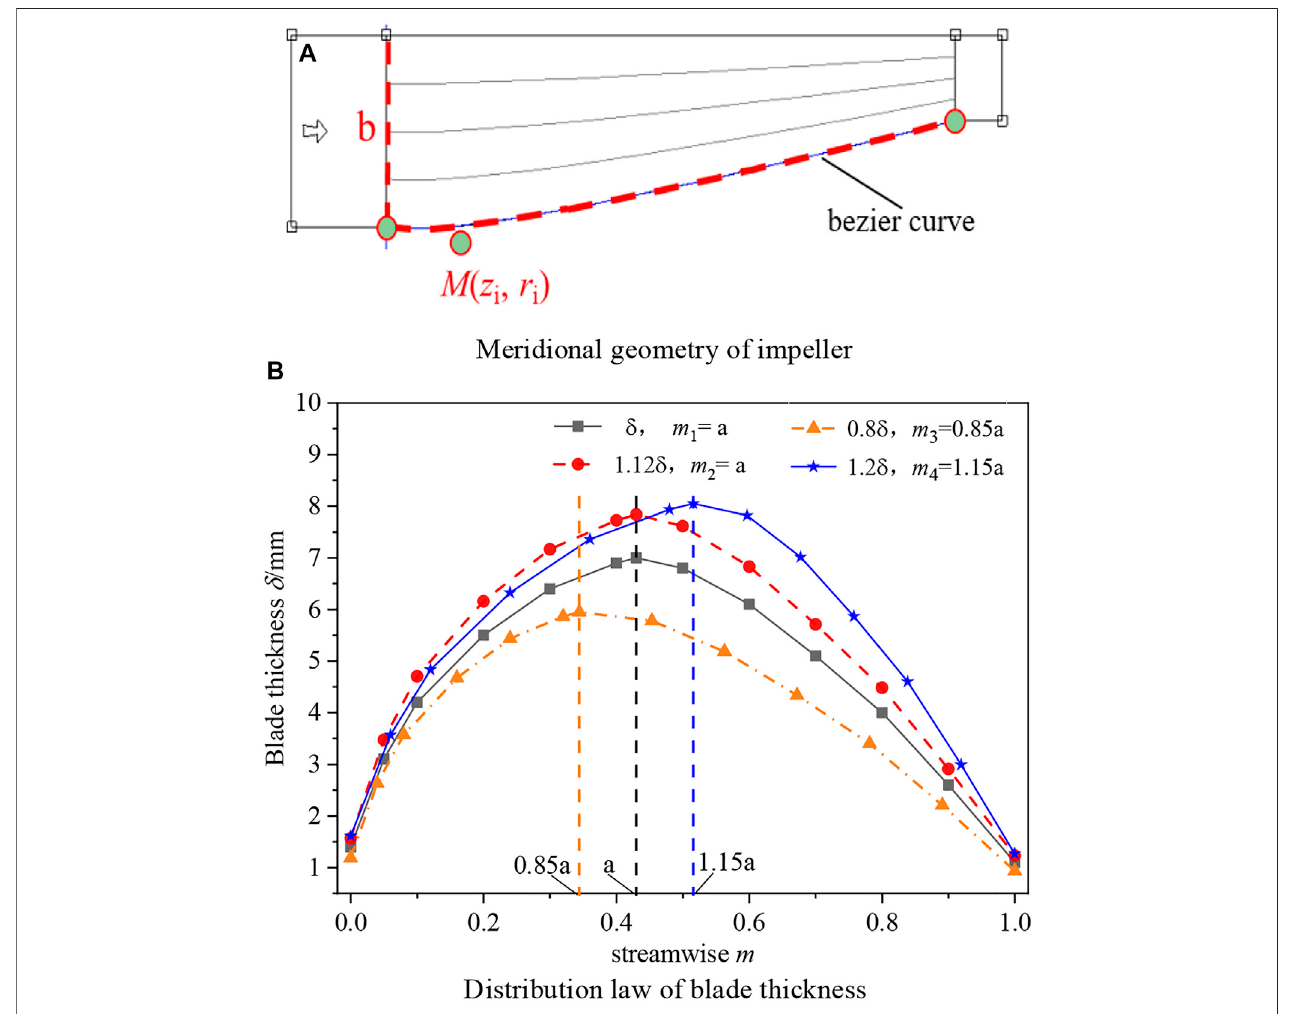
FIGURE 4 | Distribution law of meridional geometry and blade thickness of impeller. (A) Meridional geometry of impeller. (B) Distribution law of blade thickness.